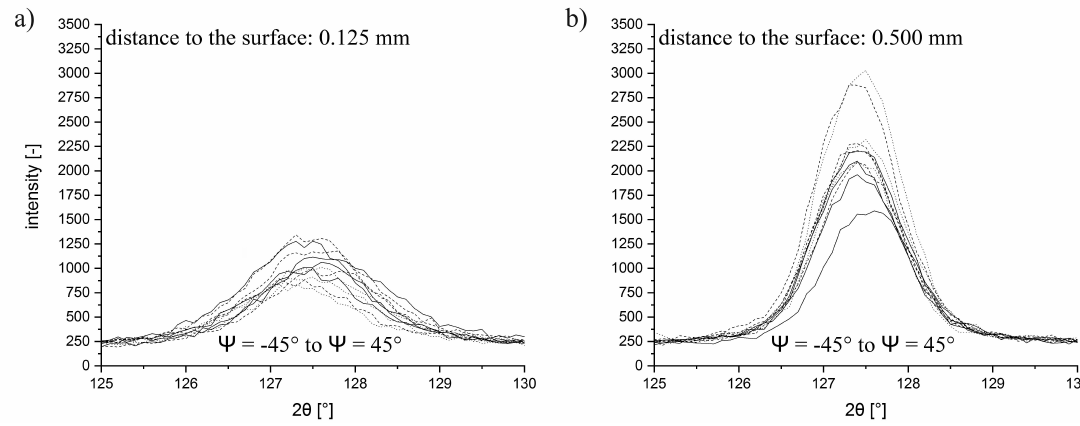
Figure 10. XRD peaks used for determination of residual stresses in a depth of 0.125mm ( a ) and 0.500mm ( b ), respectively, plotted for Ψ -angles ranging from − 45 ◦ to 45 ◦